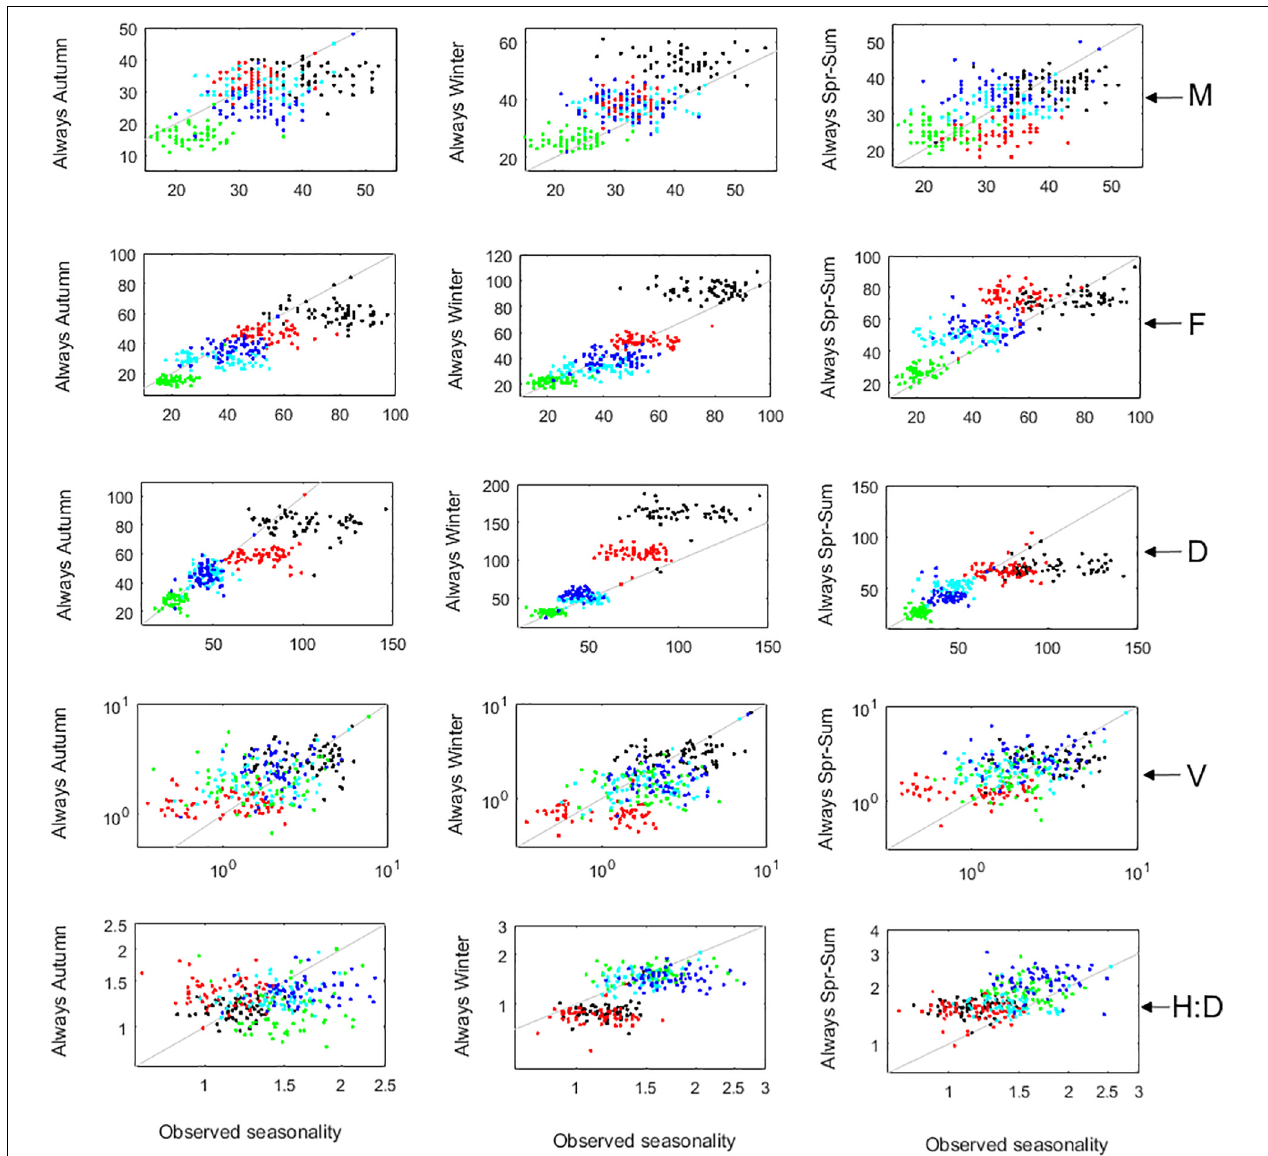
FIGURE 13 | The effects of seasons on the demography of A. chilense . Comparison between observed seasonality and the predicted algal stand if it was always the same season. M, F, and D are the abundances of males, females, and diploids, respectively. V is the total frond volume per square meter. H:D is the ratio of haploids to diploids. Markers represent plots Corral 1 (black), Corral 2 (red), Niebla 1 (green), Niebla 2 (light blue), and Niebla 3 (dark blue). Gray line represents the 1:1